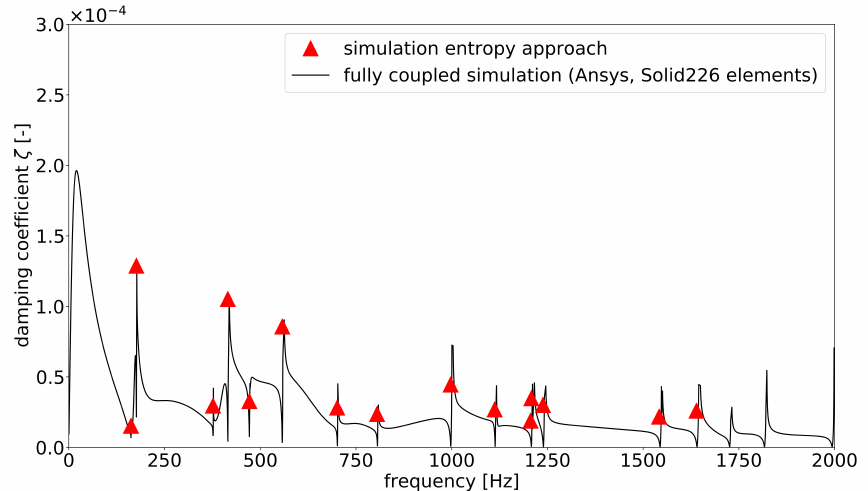
Figure 6. Comparison of the damping coefficients of the modal-based entropy approach with the fully coupled thermoelastic ANSYS simulation for the rectangular